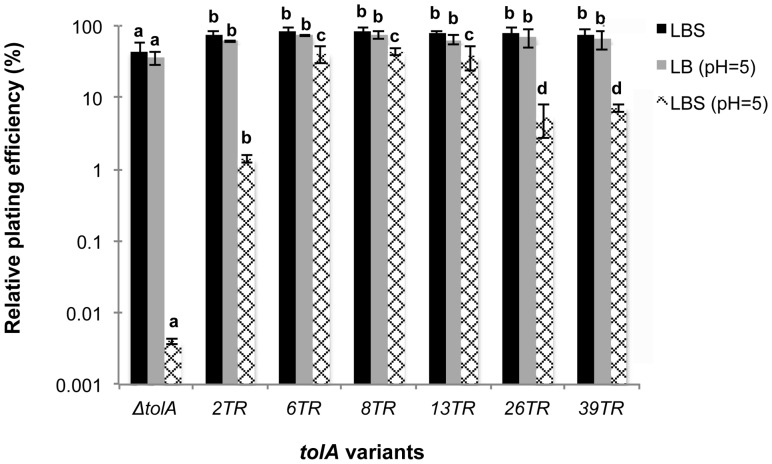
Relative plating efficiencies of MG1655 TolA TR variants on LBS (0.6 M NaCl), LB pH 5 and LBS pH 5 medium.13TR refers to the reconstructed MG1655 TolA13TR strain which is identical to and produced the same results as the wild-type strain MG1655. Error bars represent standard deviations of three independent biological replicates. Columns of the same series marked with a different letter are significantly different at 0.05 level by Analysis of Variance (ANOVA) of log-transformed data followed by LSD post hoc test.